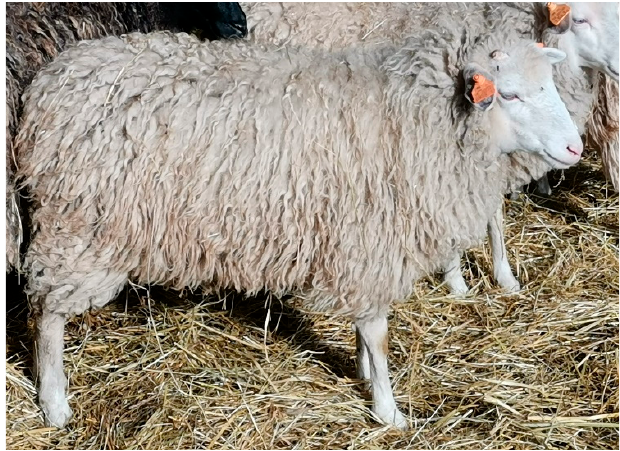
Figure 1. Ś winiarka sheep. Figure 1. ´Swiniarka sheep.